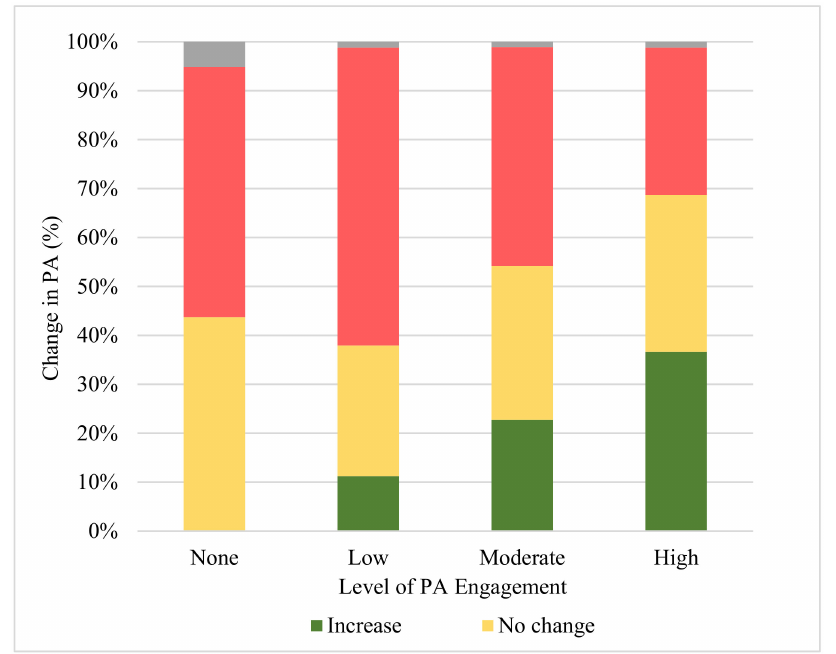
Figure 1. Change in PA by current level of PA engagement (n = 11,775). Note: The denominators of this figure are current level of PA engagement. A chi square test was conducted to test the association between current level of PA engagement and the change in PA, with X 2 = 1848.6 and p <